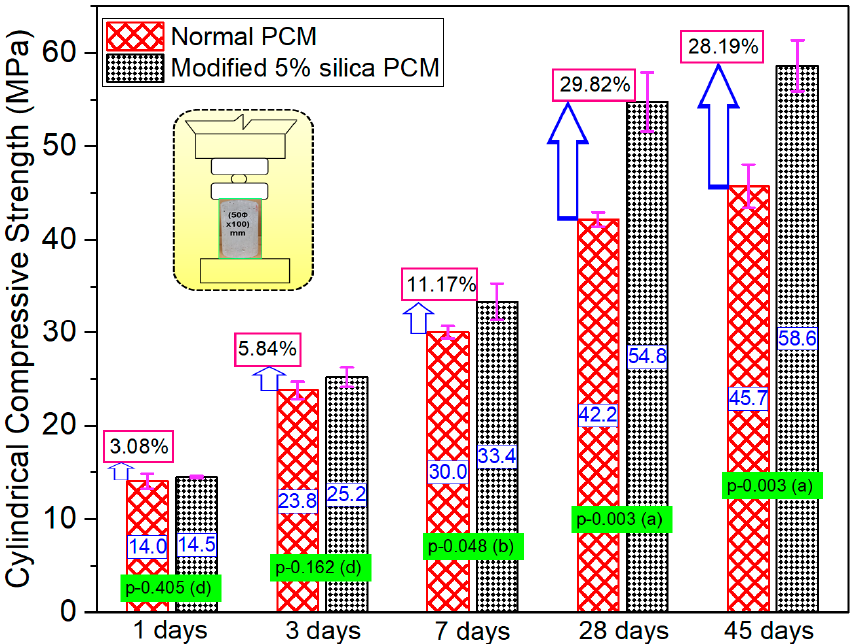
Figure 13. Influence of silica fume on monolithic specimens.